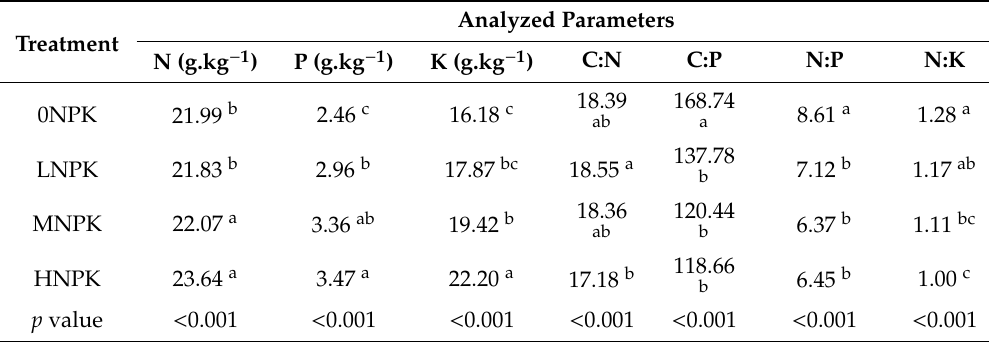
Table 5. Average content of nutrients and nutrient ratios.